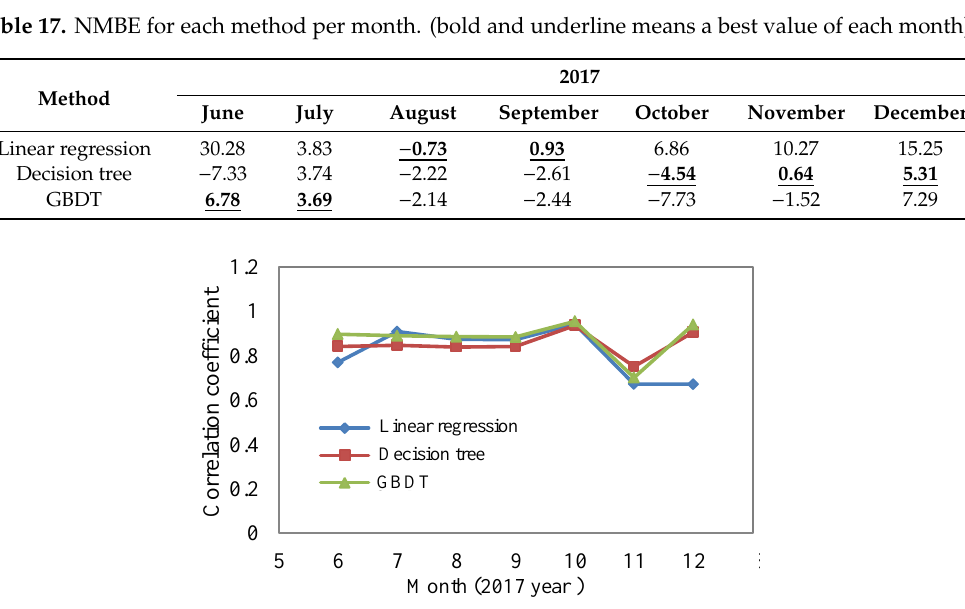
Figure 9. Transition of coefficient of determination for each method per month.